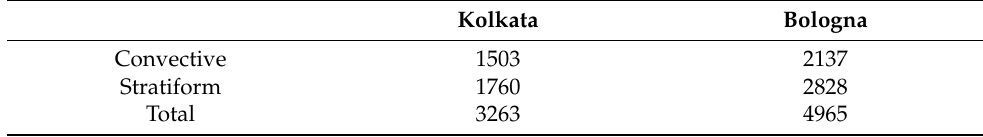
Table 1. Number of DSDs in the C/S